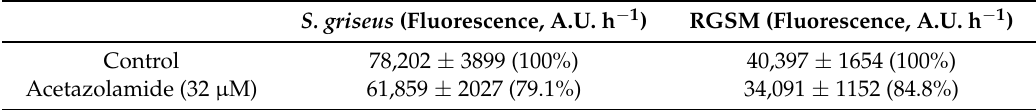
Table 3. Inhibition of the chitinase activity of RGSM and S. griseus by acetazolamide. The inhibitory effect of acetazolamide was tested according to the protocol of Schuttelkopf et al. [23].